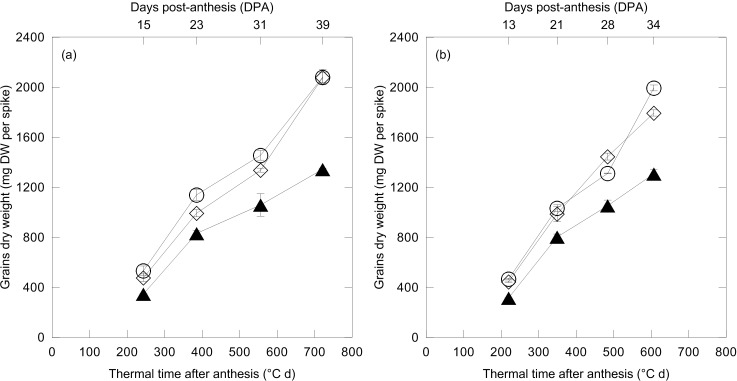
Changes of grain dry weight (mg DW per spike) against thermal time after anthesis (cumulative average daily air temperature exceeding 0°C, °C d) and days post-anthesis (DPA) (above axis) of durum wheat in 2011 (a) and 2012 (b). Wheat plants were exposed to control conditions (unfertilized CONTROL, black triangle) and to two N fertilization treatments with urea (UREA, white rhombus) and calcium nitrate (NITRATE, white circle) at the rate of 150 kg N ha-1 (mean value ± standard errors, n = 3 independent replicates; split-plot ANOVA over thermal time after anthesis; effects: (a) treatment, P < 0.01; time, P < 0.01; treatment x time, P< 0.01; (b) treatment, P < 0.01; time, P < 0.01; treatment x time, P< 0.01).